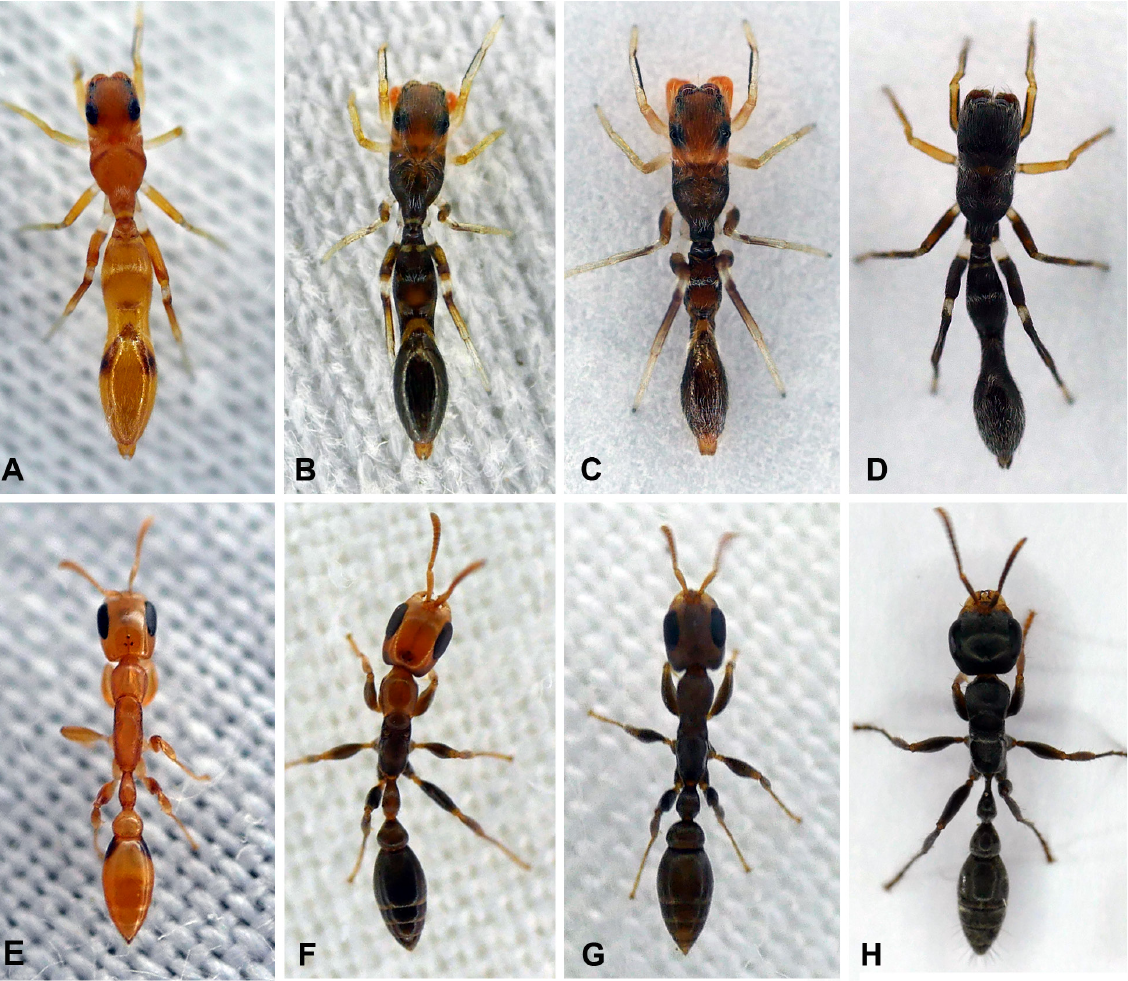
Fig. 6. A–D . Color variants and potential model ants for Synemosyna aurantiaca (Mello-Leitão, 1917). A . Orange female, Santiago de Chiquitos, Santa Cruz Dept. B . Reddish brown female, Cotoca, Santa Cruz Dept. C . Reddish brown male, Bermejo, Santa Cruz Dept. D . Dark brown male, Arambulo, Tarija Dept. E . Pseudomyrmex simplex (Smith, 1877). F . P. filiformis (Fabricius, 1804). G . P . elongatus (Mayr, 1870). H . P. gracilis (Fabricius,